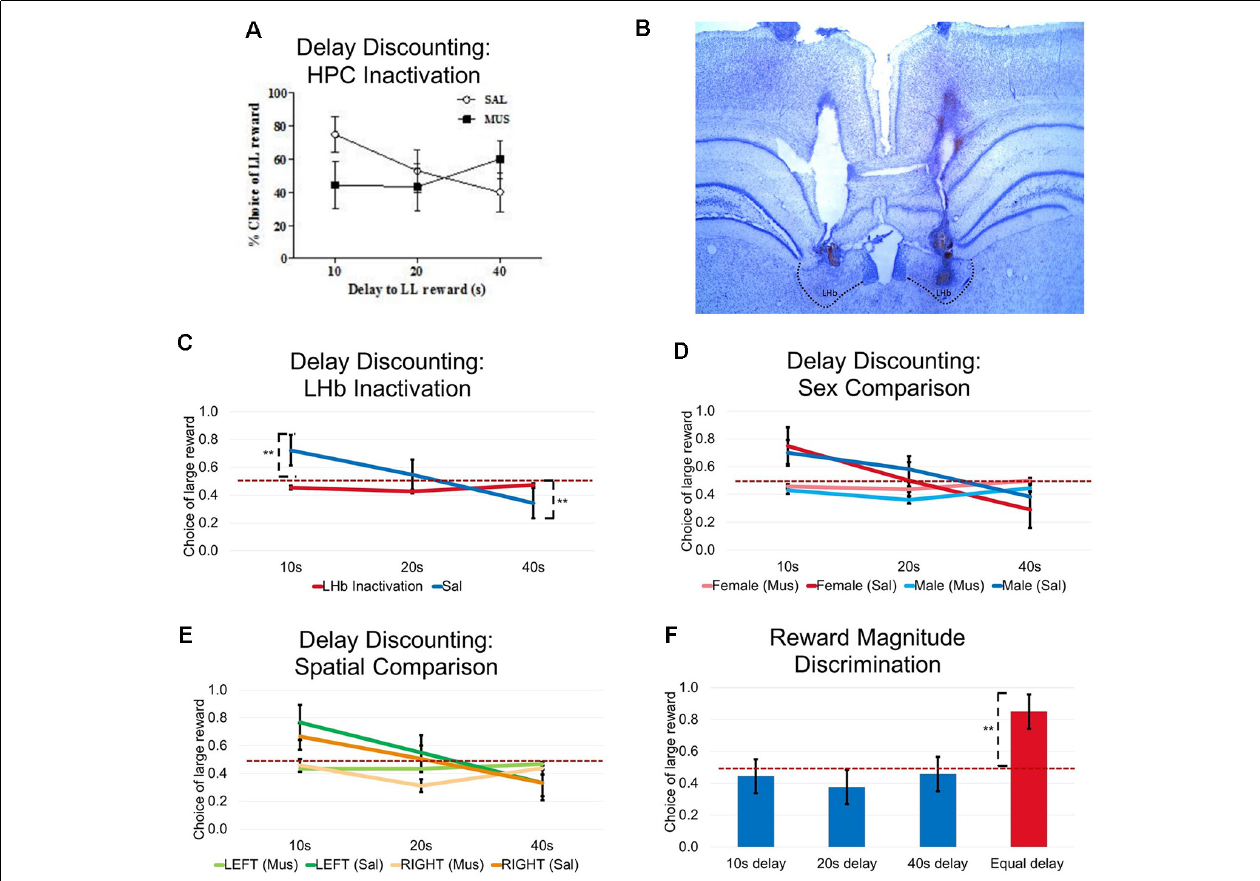
FIGURE 6 | Experiment 3: Bilateral LHb inactivation resulted in impaired performance in delay-discounting task. (A) Bilateral HPC inactivation resulted in significantly impaired performance during the delay-discounting task. The figure shown was adapted from Davis et al. (2016). (B) Histological illustration of cannula placements in the LHb. (C) Bilateral LHb inactivation resulted in a significant impairment in delay-discounting task. There was a significant interaction effect ( F ( 2,16 ) = 34.725, P < 0.01), no drug effect ( F ( 1,8 ) = 3.510, p = 0.098, ns.), and a significant delay effect ( F ( 2,16 ) = 15.561, p < 0.01). (D) Impairments were not due to sex differences. No interaction effect was observed after muscimol infusion ( F ( 2,14 ) = 0.206, p = 0.816, ns.), and no significant effect of sex was observed ( F ( 1,7 ) = 0.012, p = 0.916, ns.). No interaction effects were observed under saline infusion ( F ( 2,14 ) = 0.371, p = 0.697, ns.) nor was there a significant sex effect ( F ( 1,7 ) = 0.177, p = 0.687, ns.). (E) Impairments were not due to a spatial bias toward one or the other reward locatinos. No interaction effect was found after muscimol infusion ( F ( 2,14 ) = 0.127, p = 0.882, ns.) and and there was no effect of reward location ( F ( 1,7 ) = 0.057, p = 0.819, ns.). No interaction effects were seem after saline infusion ( F ( 2,14 ) = 2.268, p = 0.140, ns.) and there was no effect of reward location ( F ( 1,7 ) = 2.356, p = 0.169, ns.). (F) Intact reward magnitude discrimination was observed after LHb inactivation. Given a consistent delay for either small or large reward choices, animals preferred locations associated with a larger reward, paired sample t -test ( t = 10.513, p < 0.01). ∗∗ p < 0.01. ns = not significant.